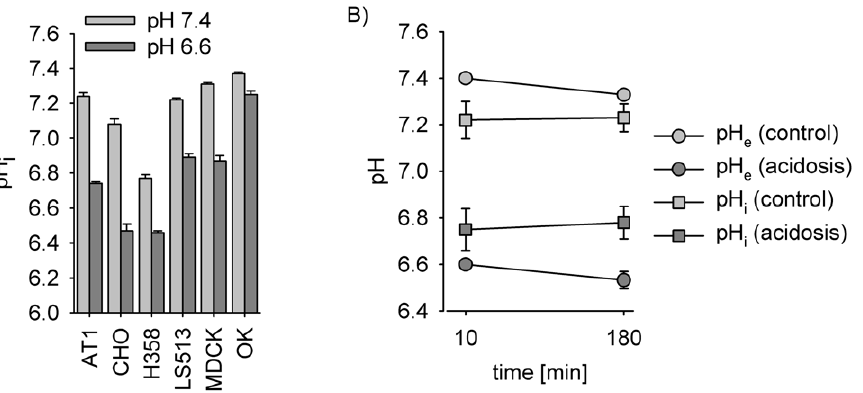
Figure 1. Effects of pH e on pH i in different cell lines. (A) pH i measured under control conditions (pH 7.4) and during extracellular acidosis (pH 6.6) (N=3–7). (B) pH-gradient in AT1 cells under control (pH 7.4) and acidic (pH 6.6) conditions for two different time points; circle: pH e , square: pH i .